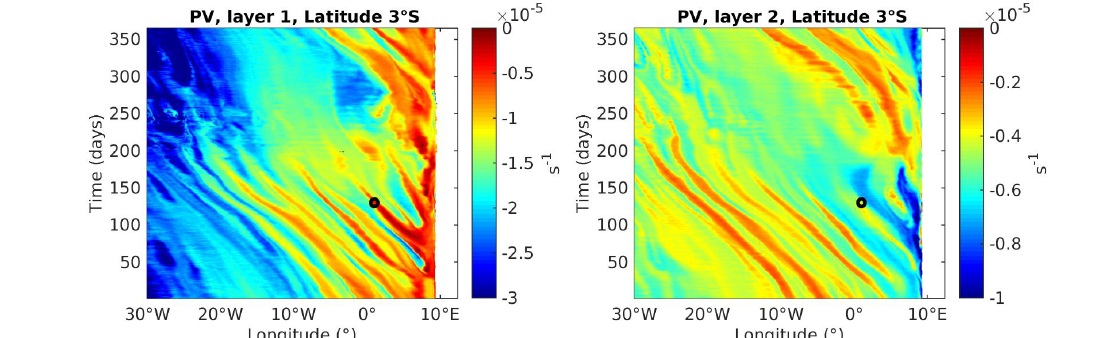
Figure 8. Hovmöller diagram of PV along 3 ◦ S for the whole year 2015 in layers 1 (left panel) and 2 (right panel). The black circles indicate the position of the vortex analysed in details and which is formed just before the equatorial upwelling